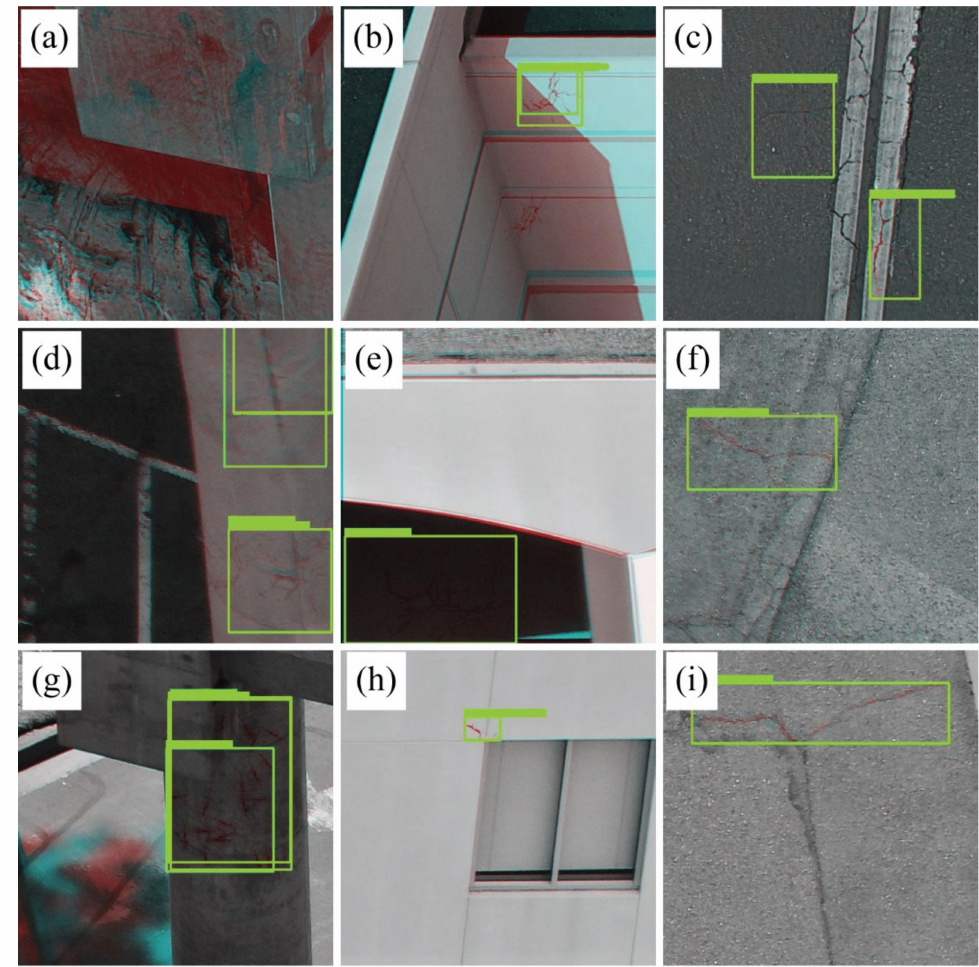
Figure 6. Examples of damage detection, where the green boxes indicate the models detected damage. ( a ) through ( c ) were generated with the Mavic 1 non-RSI images and model, ( d ) through ( f ) were generated with the Matrice 300 non-RSI images and model, and ( g ) through ( i ) were generated with the Matrice 300 RSI images and model. ( a ) bridge, damage missed, ( b ) building, 1 of 2 damage instances detected, ( c ) road, both instances of damage detected, ( d ) bridge, 1 instance of damage de- tected, 1 false-positive detection, ( e ) building, damage detected, ( f ) road, damage detected, ( g ) bridge, damage detected, ( h ) building, damage detected, ( i ) road, damage detected.